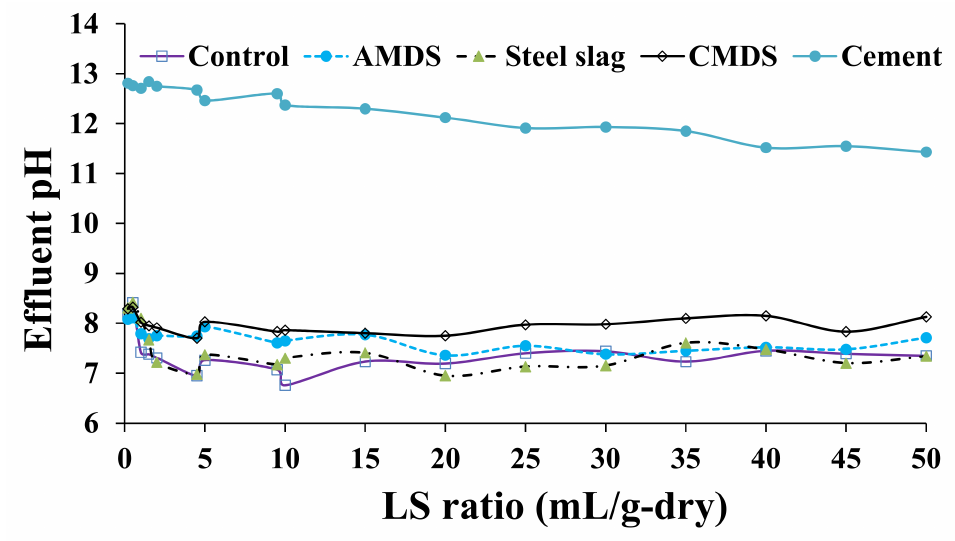
Figure 2. Eluate curves for the pH as a function of the L/S ratio in the column percolation test using different stabilizers within the contaminated